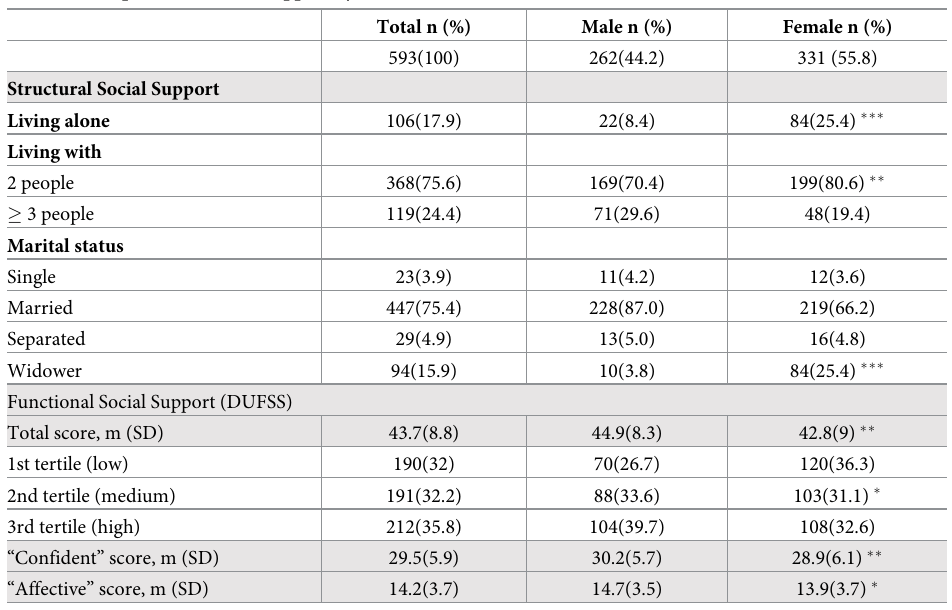
Table 2. Components of social support by